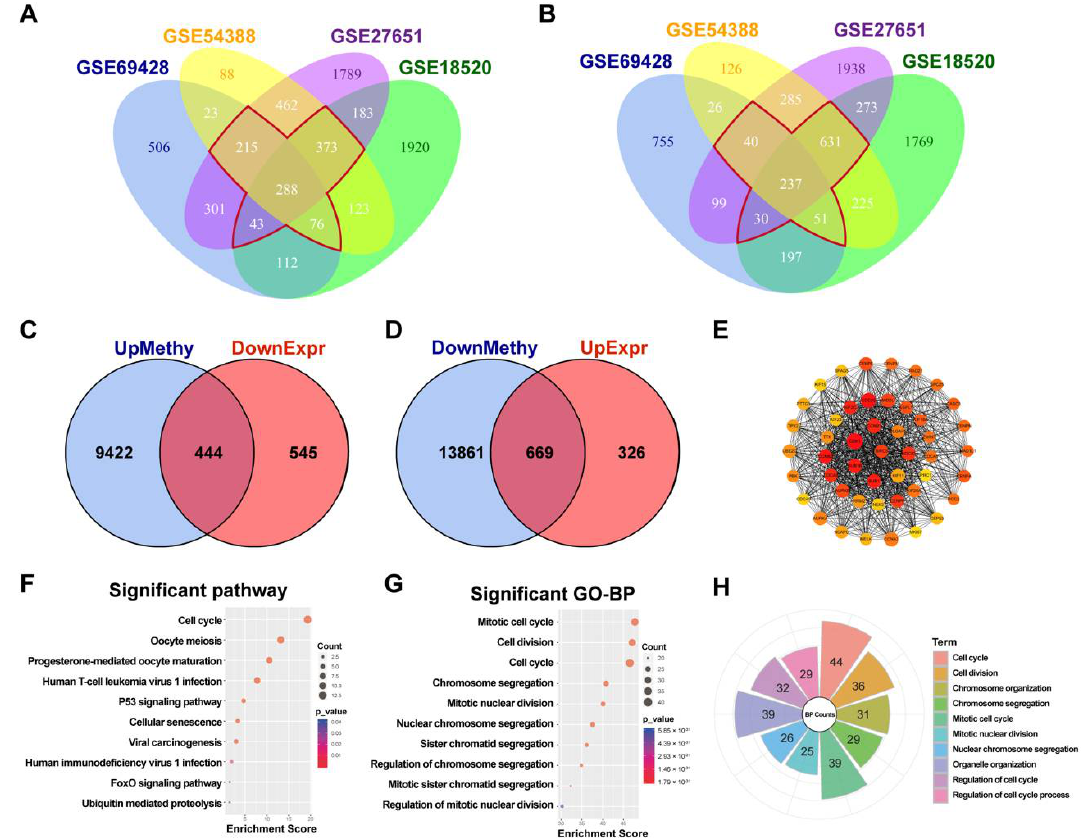
Figure 1. Identification of MeDEGs in HGSOC. ( A ). The intersection of the upregulated DEGs in the above four expression profiles; the red flower indicates the 995 genes that were upregulated in at least three of the expression profiling datasets. ( B ). The intersection of the downregulated DEGs in the above four expression profiles; the red flower indicates the 989 genes that were downregulated in at least three of the expression profiling datasets. ( C ). The overlap of hypermethylated DMGs and downregulated DEGs. ( D ). The overlap of hypomethylated DMGs and upregulated DEGs. ( E ). The top 47 hub genes with the highest connectivity, the color of the node indicates the connectivity in the PPI network, and the redder the color is, the greater the connectivity. ( F ). The KEGG analysis of the top 47 hub MeDEGs showed that the 47 hub genes were mainly enriched in the cell cycle pathway. ( G , H ). The GO analysis of the top 47 hub MeDEGs in biological processes (BP) showed that the 47 hub genes were mainly enriched in the cell cycle pathway; a total of 44 genes were enriched in the cell cycle pathway, including UBE2C.